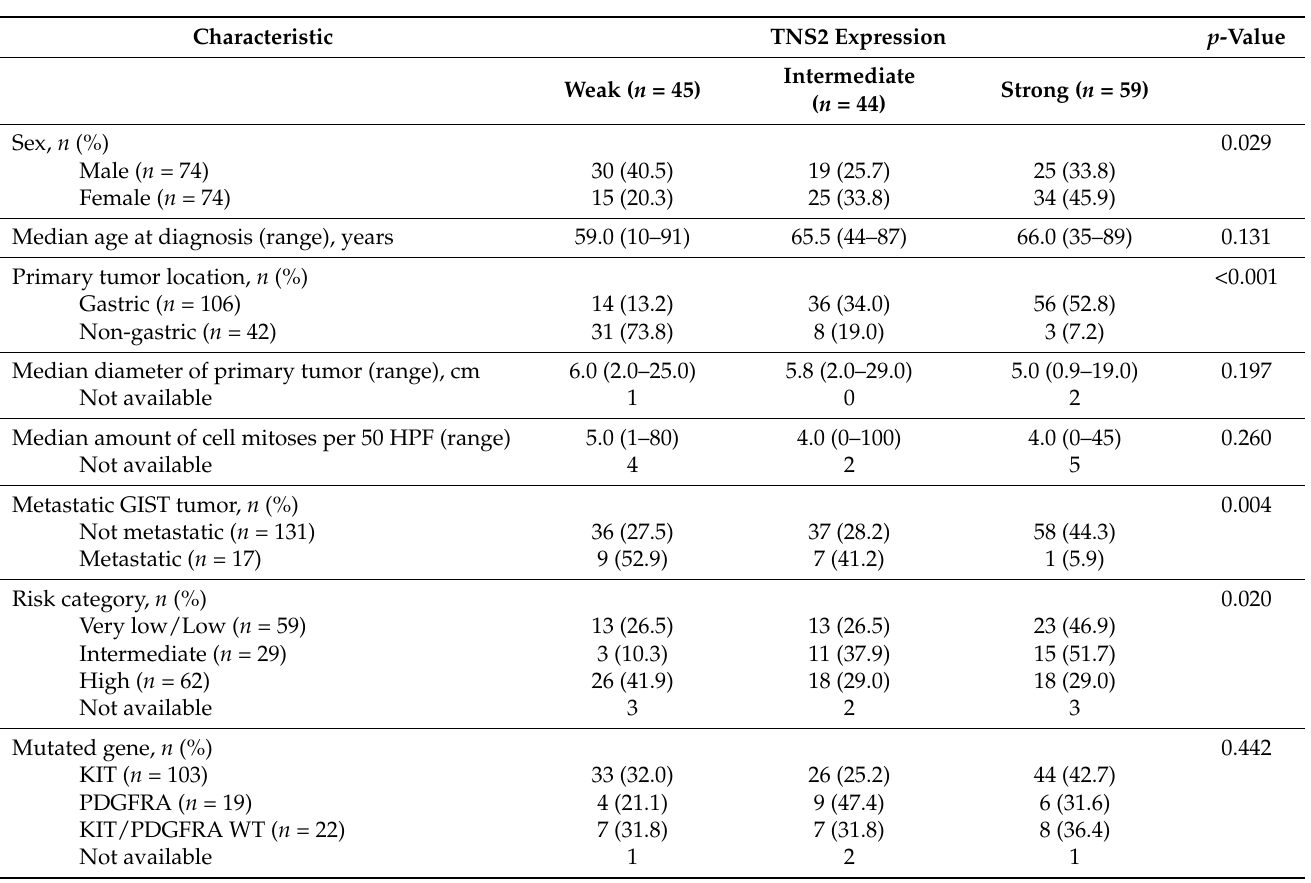
Table 4. TNS2 immunostaining and clinicopathological features of the 148 GIST patient sample